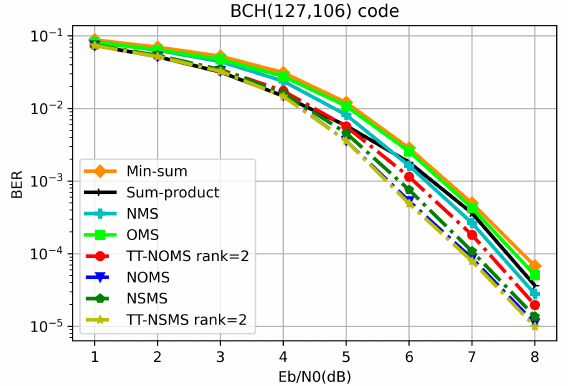
Figure 4. BER performance of TT-NOMS, TT-NSMS, NOMS [22] and NSMS algorithms for BCH(63,45) code.